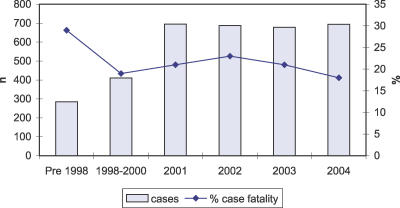
Annual Admissions of Children with Severe Malnutrition and Case Fatality RatesPrior to 2000, malnutrition was defined as weight for age (WAZ) less than −4 or oedematous malnutrition. Annual admissions rates: 1991–1998 (3,800), 1998–2000 (4,877), 2001 (5,136), 2002 (4,878), 2003 (5,583), and 2004 (5,004).